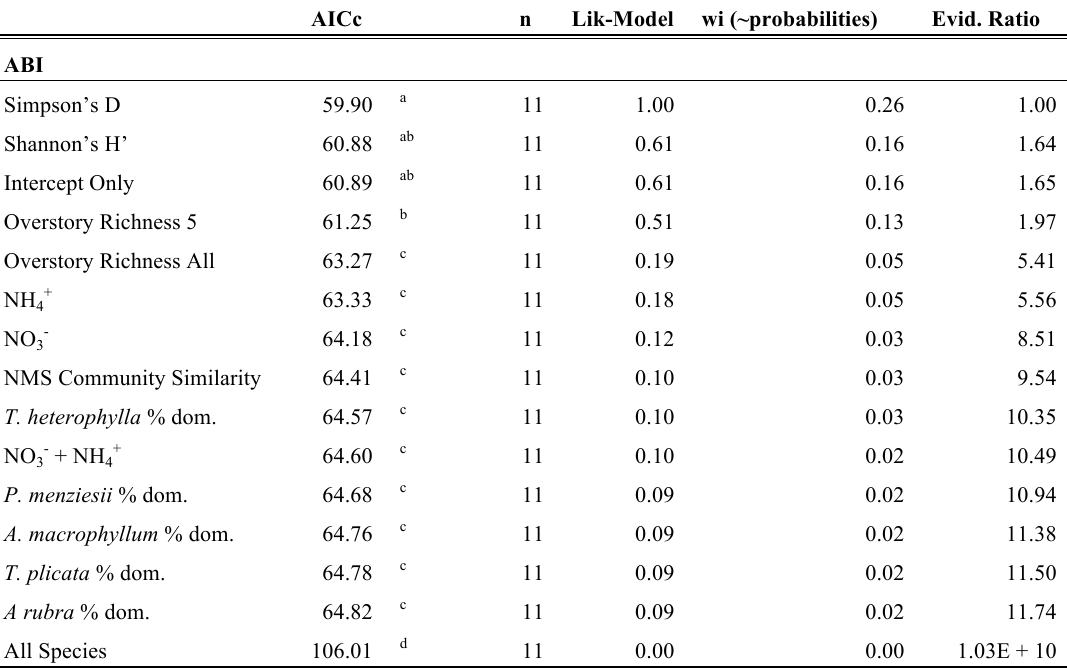
Table 3. Model selection ranking * for the best models predicting aboveground biomass increment (ABI) in plots where N data were also